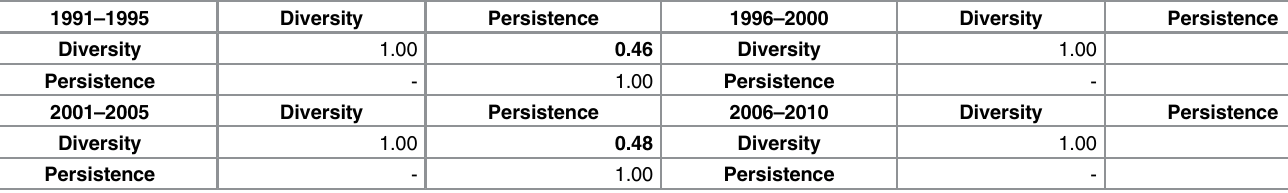
Table 7. Pearson Correlations between Diversity and Persistence